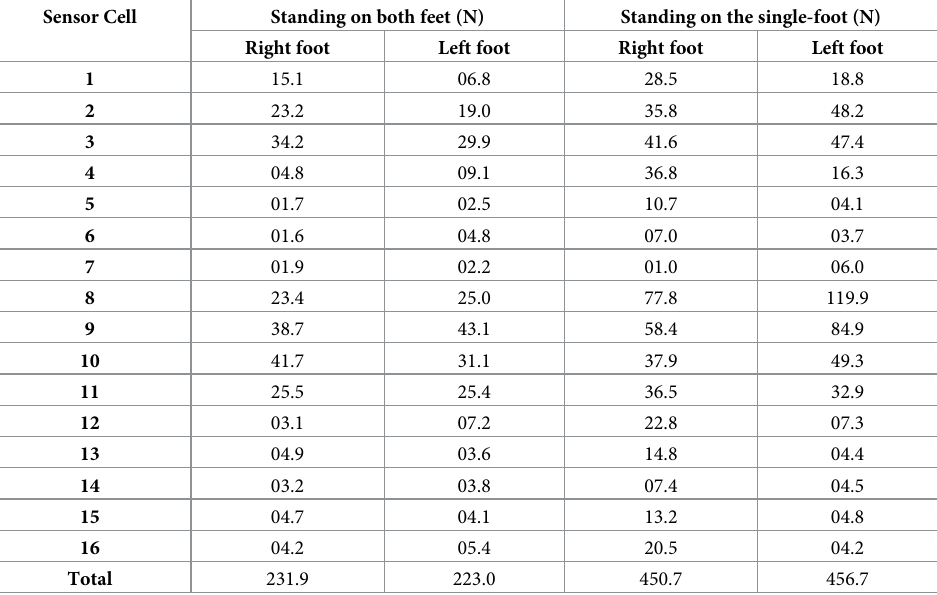
Table 1. Static plantar pressure force under natural standing position. Sensor Cell Standing on both feet